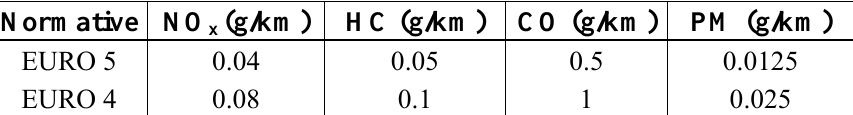
Table 17. EURO Directives on Emissions.